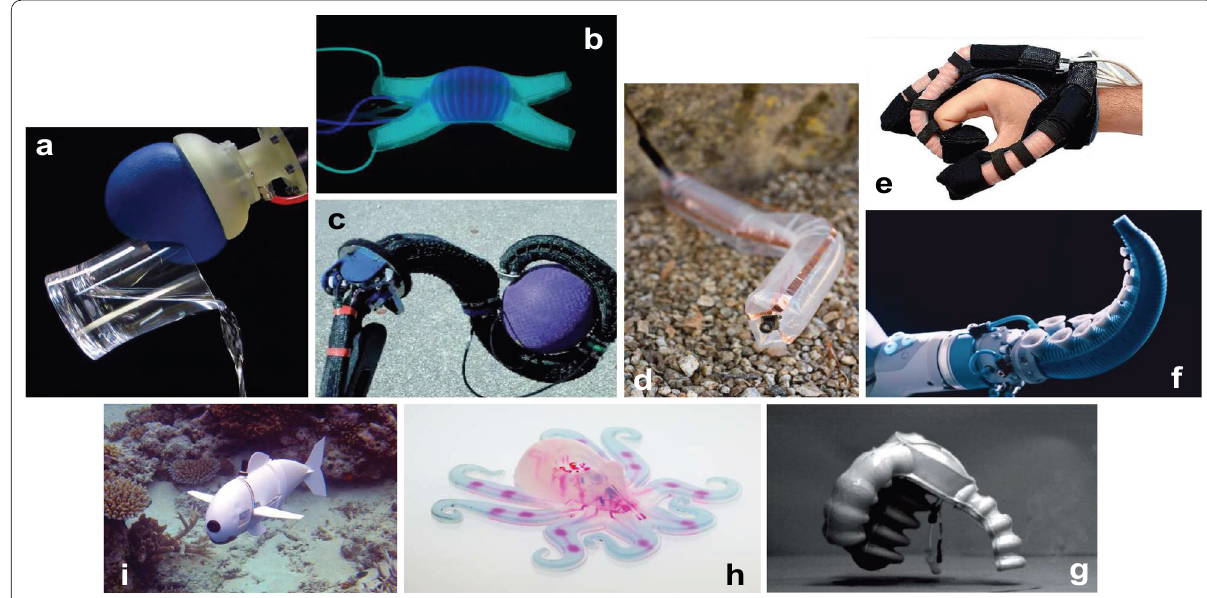
Fig. 1 Soft robots inspired by nature demonstrating superior performance over traditional robots. a Jamming-based soft gripper picking up a wide range of objects [5], b Soft quadruped robot glowing in the dark using chemiluminescence [6], c Soft-continuum manipulator grasping a sphere during field trials [7], d Soft growing robot navigating by exploiting contact with terrain [8], e Soft rehabilitation glove assisting humans with functional grasp pathologies [9], f Tapered soft gripper inspired by octopus arms providing high dexterity and flexibility [10], g Untethered soft-bodied robot executing agile locomotion [11], h Soft, autonomous robot performing untethered operation [12], i Soft robotic fish exploring underwater along coral reefs in the Pacific Ocean [13]. Images have been obtained from publicly available resources and their intellectual property belongs to the authors, sources, and publishers of the cited